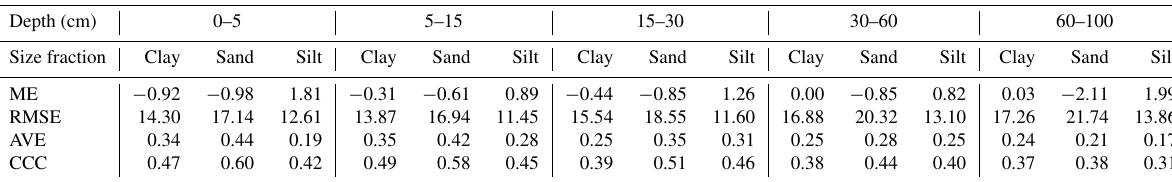
Table 5. Summary of map quality measures for spatial ensemble model for PSF in five standard depths. ME: mean error; RMSE: root mean square error; AVE: amount of variance explained; CCC: concordance correlation coefficient. These map quality measures are based on the validation